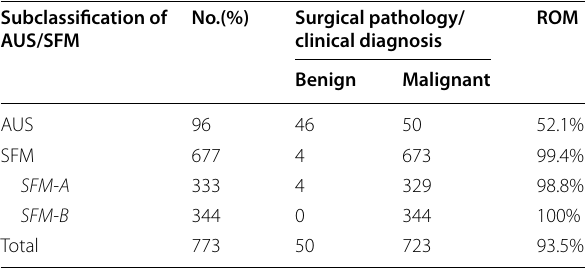
SFM-A: There were rare cells displaying moderate-to-severely atypical features that were qualitatively insufficient to confidently exclude malignancy; SFM-B: There were rare cells displaying severely atypical features that were suspicious for malignancy but quantitatively insufficient for ancillary studies Abbreviations: AUS atypia of undetermined significance, SFM suspicious of